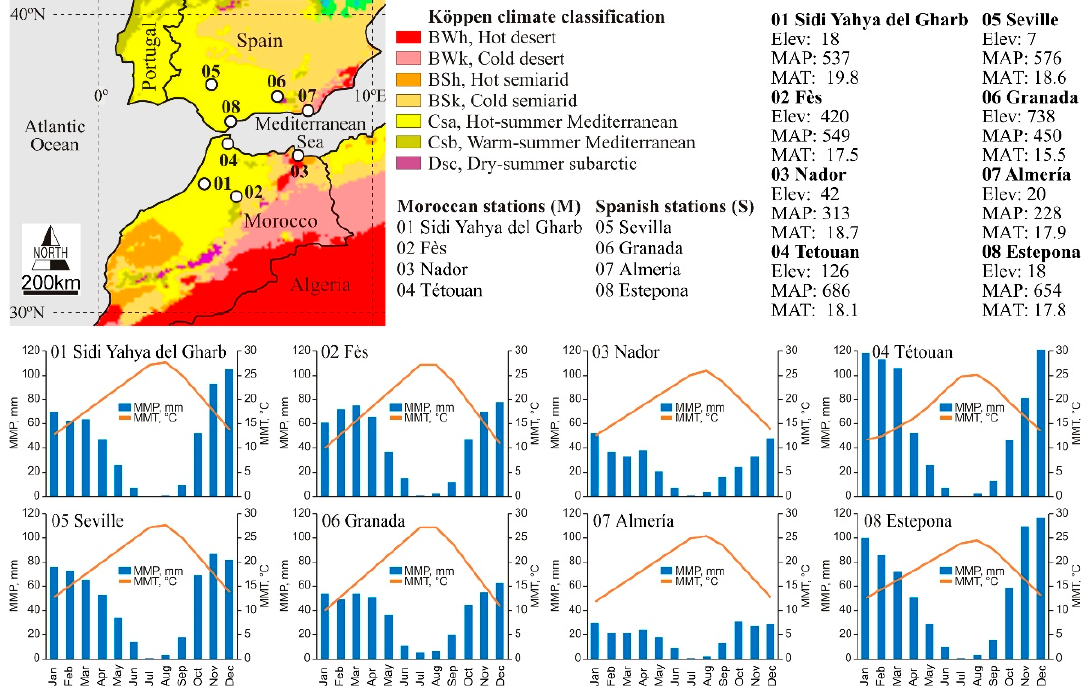
Figure 2. Four climatic and orographic equivalences between populous urban areas in northern Morocco (M) and southern Spain (S) for: low-elevation, hot-dry summer, Atlantic sub-humid in Sidi Yahya del Gharb (M) and Seville (S); medium-elevation, hot-dry summer, continental wet semiarid in Fès (M) and Granada (S); low-elevation, hot-dry summer, Mediterranean dry semiarid in Nador (M) and Almería (S); and low-elevation, hot-dry summer, Mediterranean wet semiarid in Tétouan (M) and Estepona (S). Mean monthly precipitation (MMP) in mm and mean monthly daily temperature (MMT) in °C after data compiled from the Climate-Data.Org website [https://es.climate-data.org/], accessed on January 2021. Urban areas 01 to 08 are placed over the Köppen climate classification map [39]. Elev = elevation, m above sea level (m a.s.l.); MAP = mean annual precipitation in mm; MAT = mean annual daily temperature in °C.